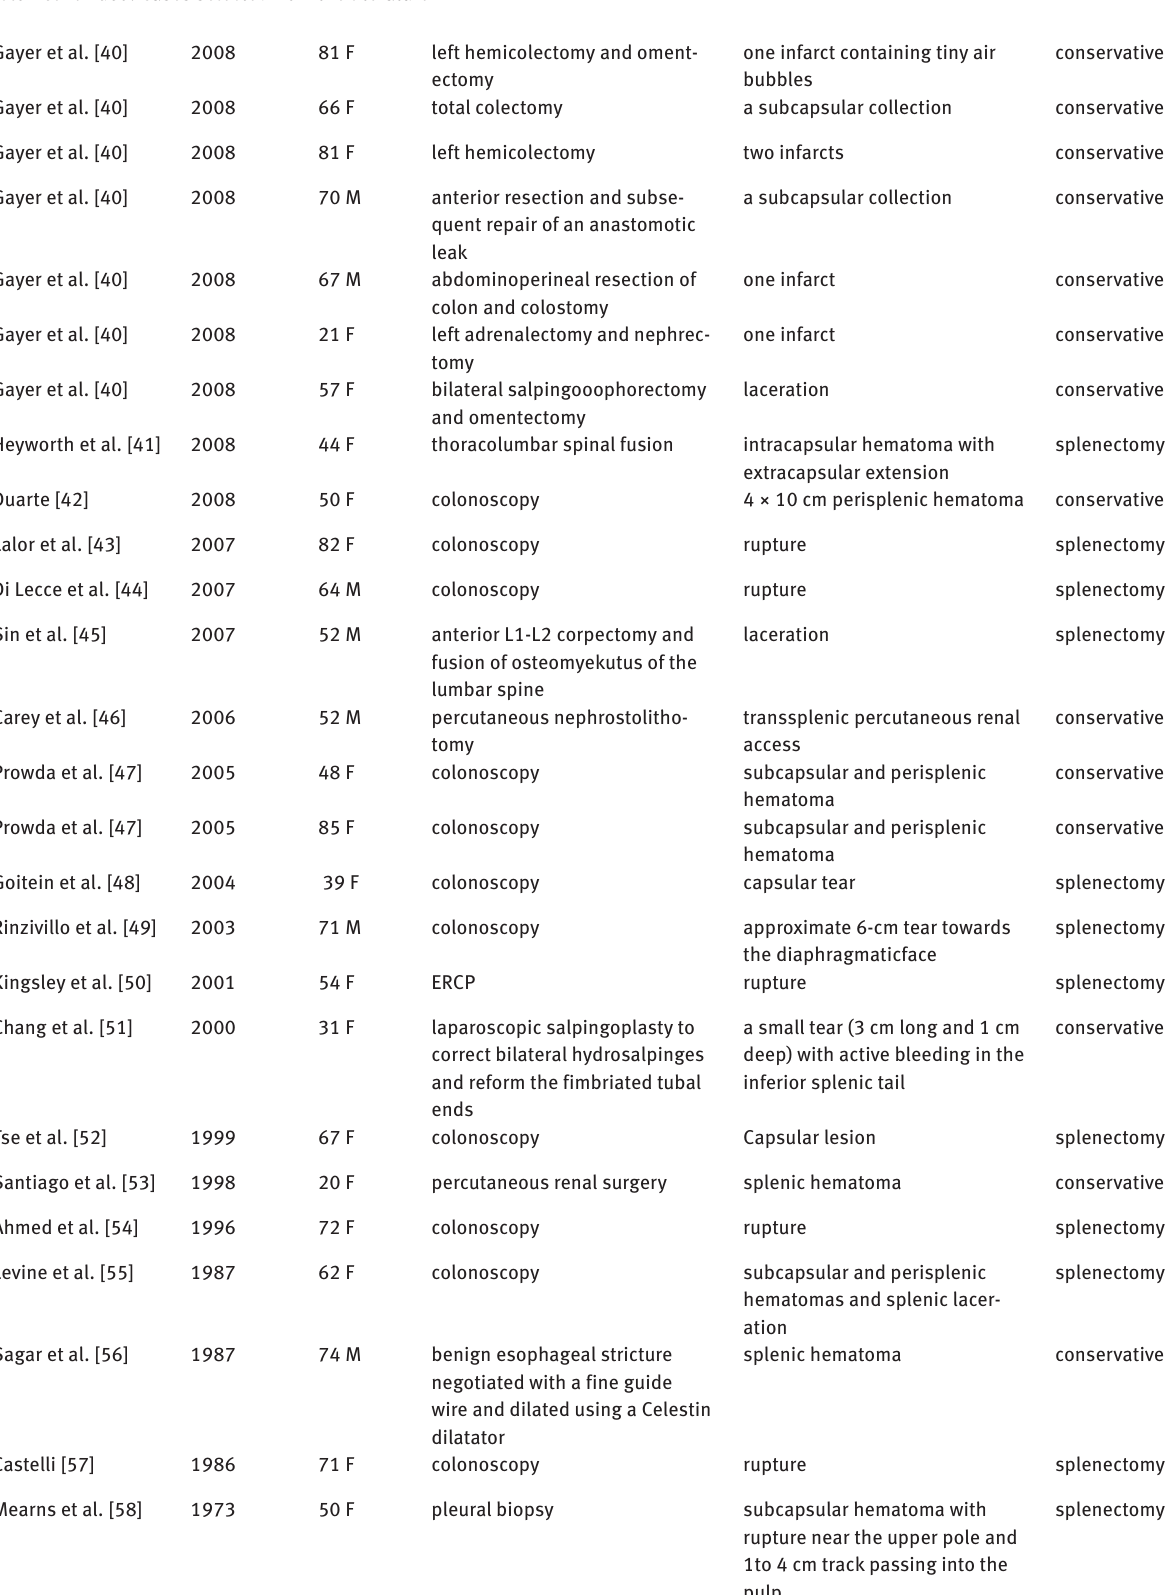
Table 1 continued: Cases selected from the